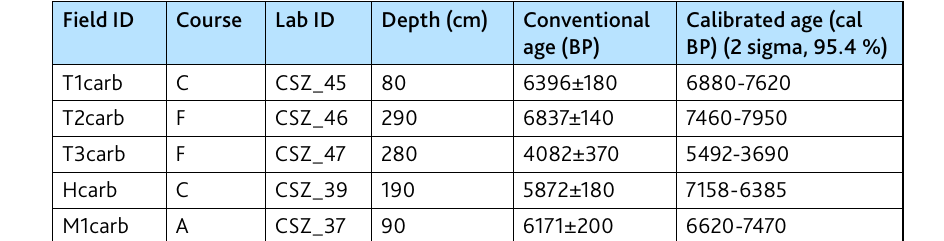
Table 3. The radiocarbon age of the dated